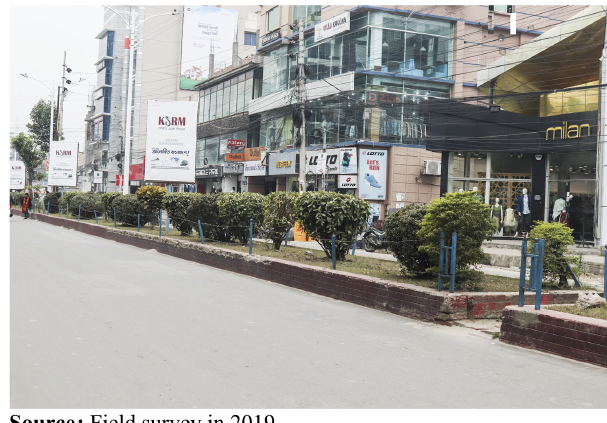
Figure 4. Landscaping of road median strips under PPP project in Khulna offered clean and green corridor